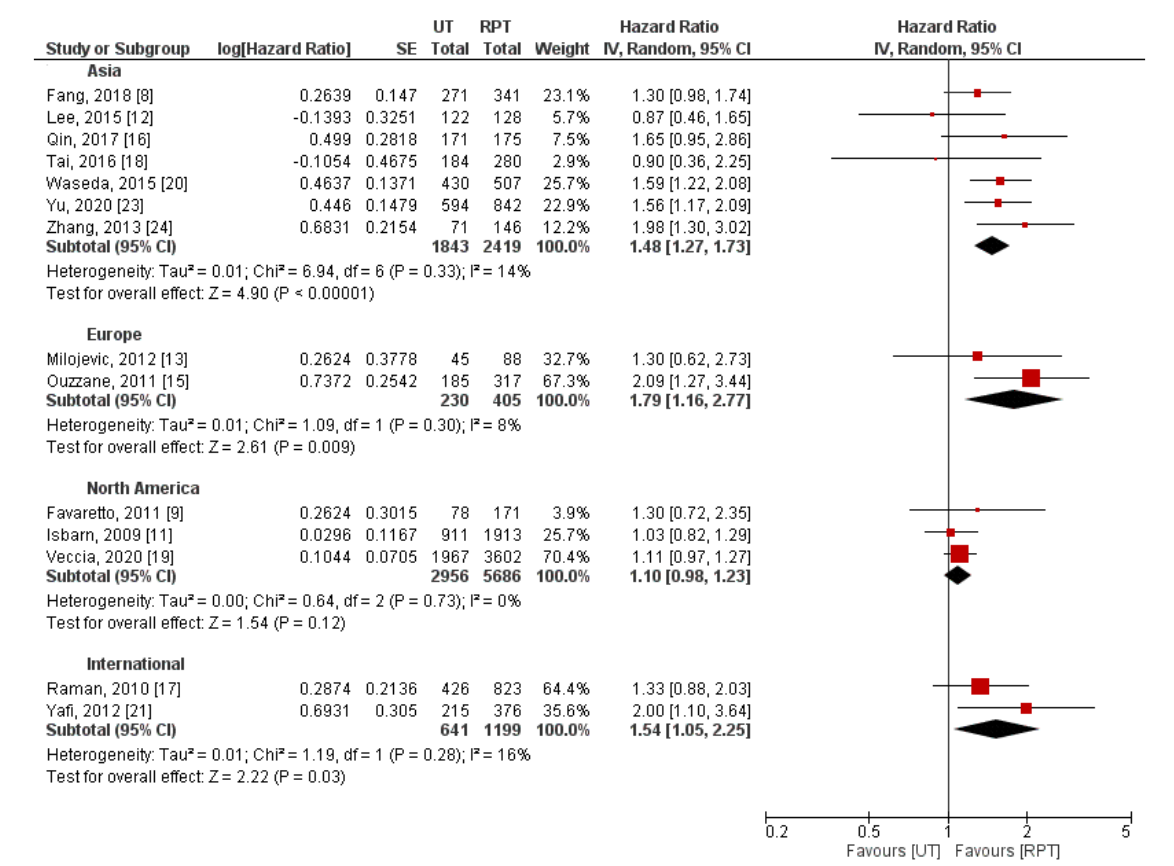
Figure 8. Forest plot and subgroup analysis of cancer-specific stratified by geographical location [8,9,11–13,15–21,23,24]. CI = confidence interval; IV = inverse variance; RPT = renal pelvic tumor; SE = standard error; UT = ureteral tumor.